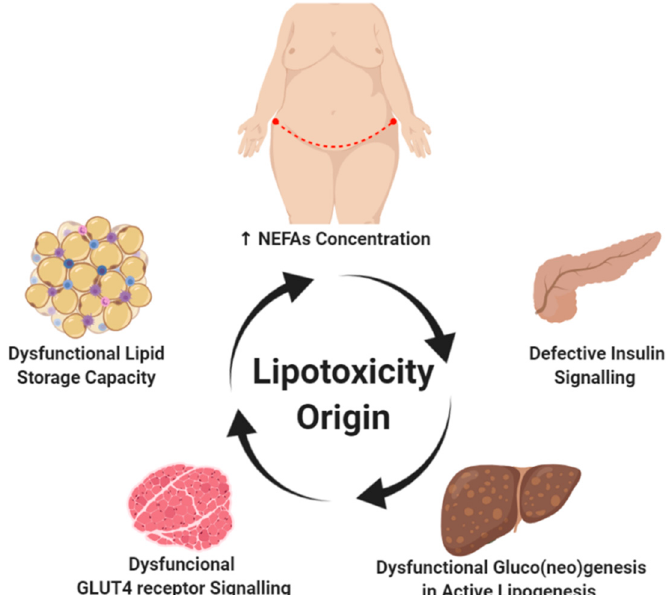
Figure 1. Lipotoxicity origin. The positive energy balance (high fat and / or carbohydrates diet) is one of the main promoters associated with obesity development. Hypertrophy and hyperplasia of white adipose tissue is a process commonly observed in the progression of obesity. The abdominal subcutaneous deposit has been associated with a greater increase in plasma non-esterified fatty acids (NEFA), a characteristic finding of insulin-resistant patients. Although the onset of lipotoxicity is unknown, altered lipid signaling by white adipose tissue and dysregulation in adipokines production is a key factor in restricting the lipid storage capacity observed in adipocytes. This limitation in the lipid deposit activates a vicious circle that leads to specific adaptations in energy metabolism in certain tissues such as the skeletal muscle, heart, liver, pancreas, and kidney, thus activating signaling pathways associated with gluco(neo)genesis in the presence of active lipogenesis. Created with BioRender.com.